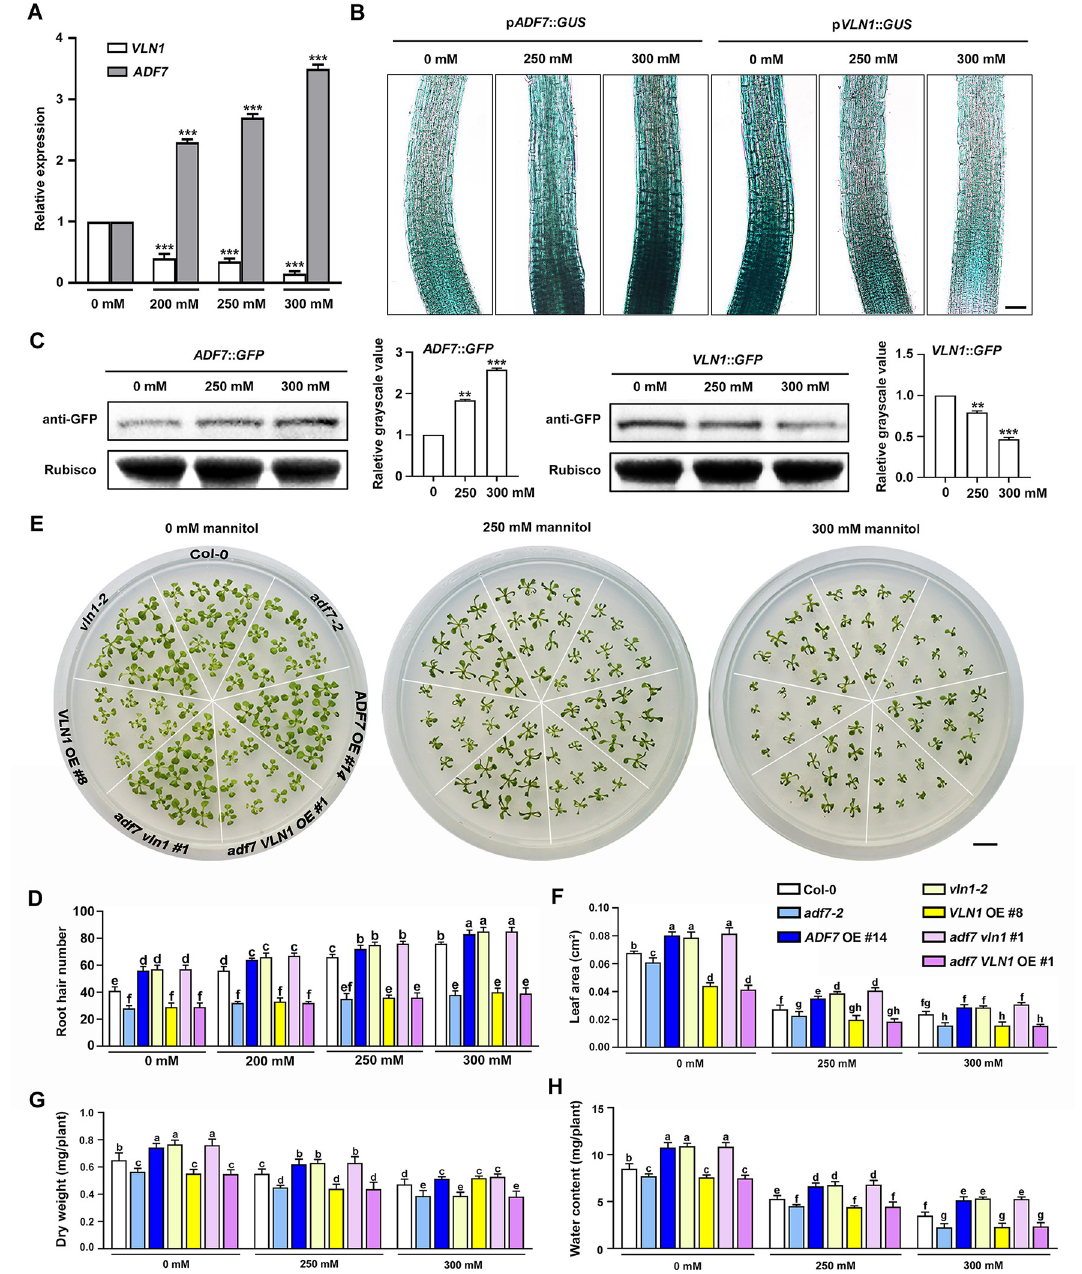
Fig 7. The pathway of ADF7-inhbited-VLN1 is crucial for root hair formation in plant osmotic stress tolerance. (A) Relative expression level of ADF7 and VLN1 in roots from 6-d-old Col-0 seedlings with 200, 250, and 300 mM mannitol treatments. Values are means ± SD of three independent biological replicates. ��� P < 0.001, Student’s t -test compared with Col-0. (B) GUS activity of 4-d-old seedlings carrying the p ADF7 :: GUS or p VLN1 :: GUS reporter gene with 0, 250, and 300 mM mannitol treatments. Scale bar, 50 μ m. (C) Western blotting using proteins extracted from different genotypes carrying the p ADF7 :: ADF7-GFP gene or p VLN1 :: VLN1-GFP gene with 0, 250, and 300 mM mannitol treatments. Rubisco was used as a loading control. Histograms depict quantification of the relative grayscale value. Values are means ± SD of three independent biological replicates. �� P < 0.01, ��� P < 0.001, Student’s t -test compared to Col-0 with 0 mM mannitol treatment. (D) Histogram depicting root hair number from ADF7 and VLN1 genotypes under 0, 200, 250, and 300 mM mannitol treatments. (E) Images of growth state from ADF7 and VLN1 genotype seedlings under 0, 250, and 300 mM mannitol treatments. Scale bar, 1 cm. (F) to (H) Phenotypic characteristics of leaf area (F) , dry weight (G) , water content (H) from 16-d-old genotype seedlings under 0, 250, and 300 mM mannitol treatments. Significant differences ( P < 0.05; indicated by different letters) among genotypes are determined for each condition by one-way ANOVA followed by Tukey’s test in (D) , (F) , (G) , and (H)